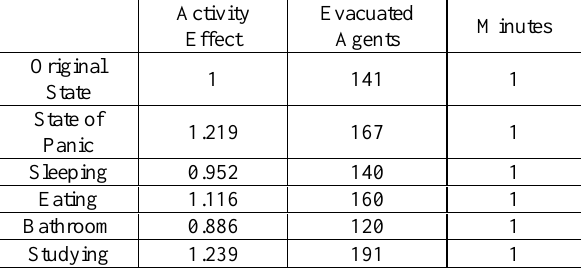
Table 2. Summary of evacuated agents per activity parameter